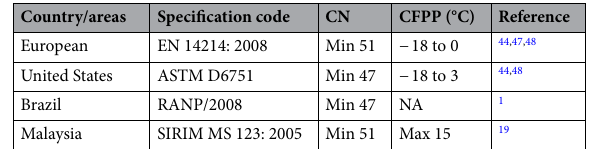
Table 2. Standard biodiesel specification (highlighted only CN and CFPP) between countries and its Methodology Cultivation of M. gracile .